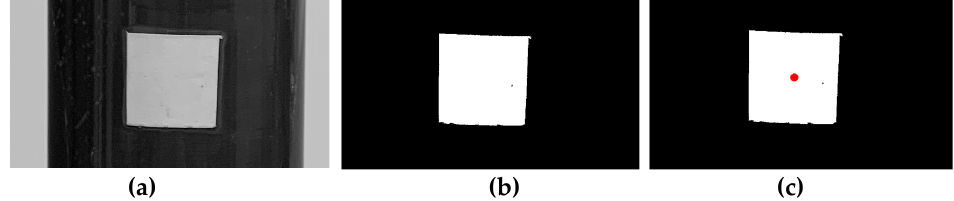
Figure 3. Sequence of the implemented image processing: original (cropped) frame ( a ), transformation into a binary frame ( b ), detection of the center of the marker ( c ).